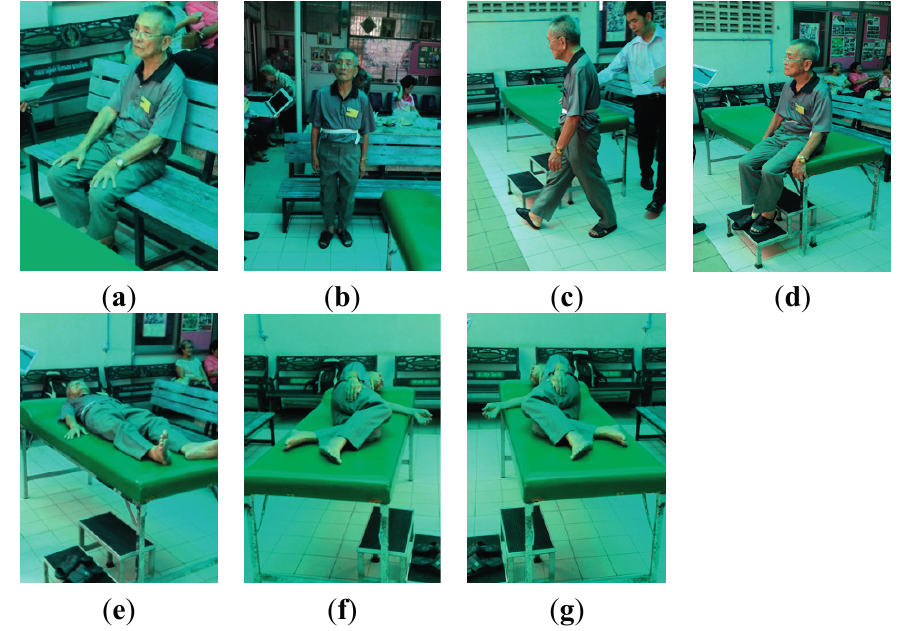
Figure 4. Activities performed by elderly subjects (DS3): ( a ) sitting on a chair; ( b ) standing; ( c ) walking; ( d ) sitting on a bed; ( e ) lying on the back; ( f ) lying left; and ( g ) lying